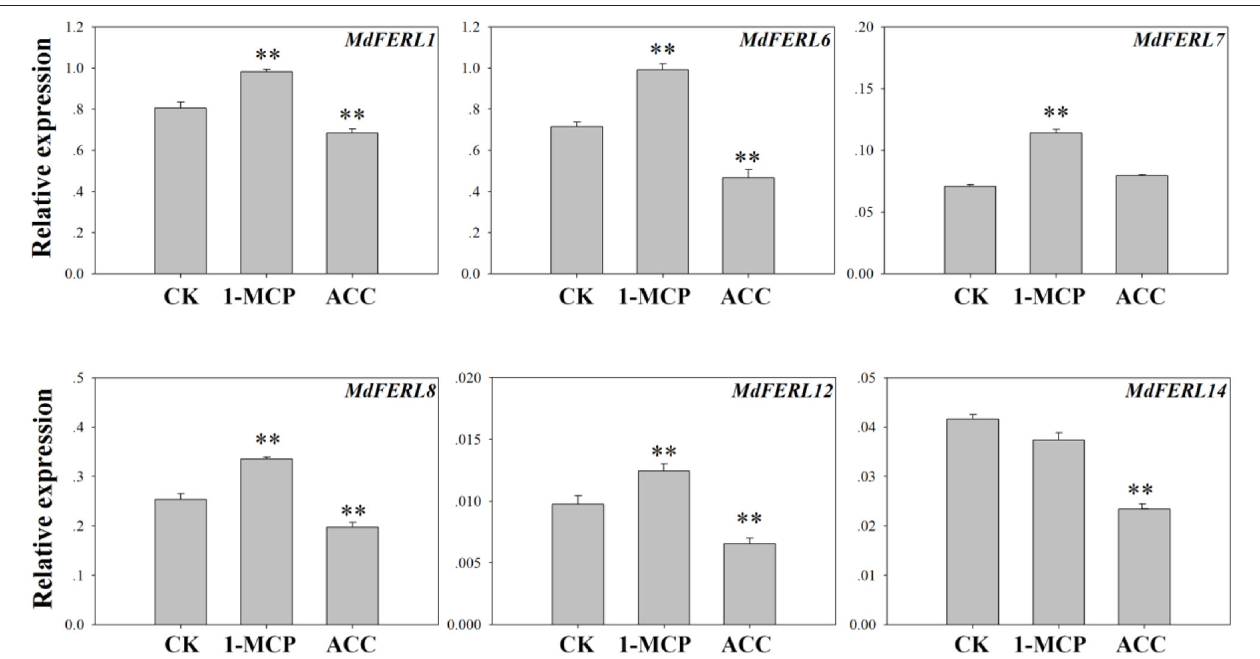
FIGURE 3 | RT-qPCR analysis of MdFERL expression in response to 1-MCP and ACC. RT-qPCR was conducted using MdACTIN as an internal control. Values are means + SD of three biological replicates. ** P < 0.01 (Student’s t -test), when compared with control values.